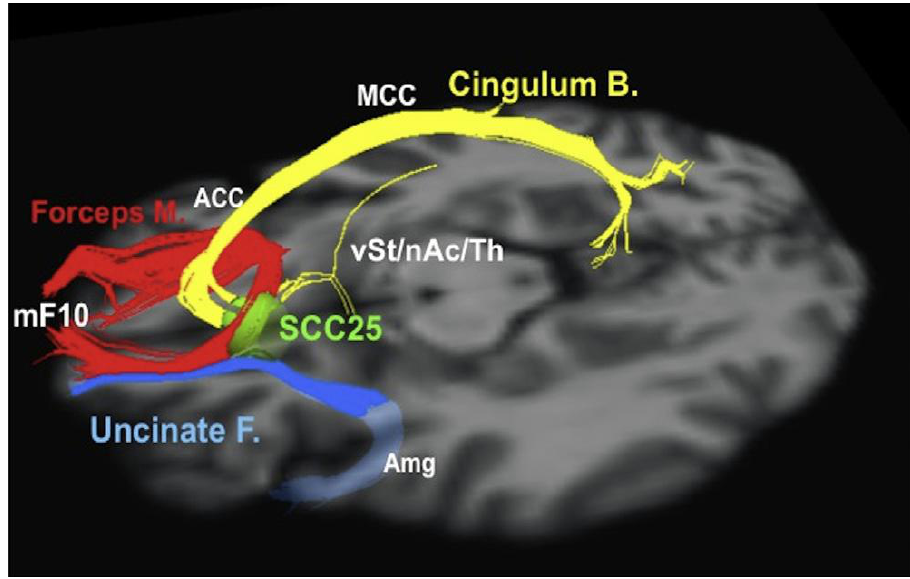
Figure 5. Subgenual cingulum. Optimal subcallosal cingulate deep brain stimulation fibre bundle target template. Red: forceps minor. Blue: uncinate fasciculus. Yellow: cingulate bundle. ACC, anterior cingulate cortex; Amg, amygdala; Cingulum B., cingulum bundle; Forceps M., forceps minor; MCC, middle cingulate cortex; mF10, medial frontal (Brodmann area 10); nAc, nucleus accumbens; SCC25, subcallosal cingulate cortex (Brodmann area 25); Th, thalamus; Uncinate F., uncinate fasciculus; vSt, ventral striatum. Reprinted from Riva-Posse et al. [57] with permission from Elsevier.